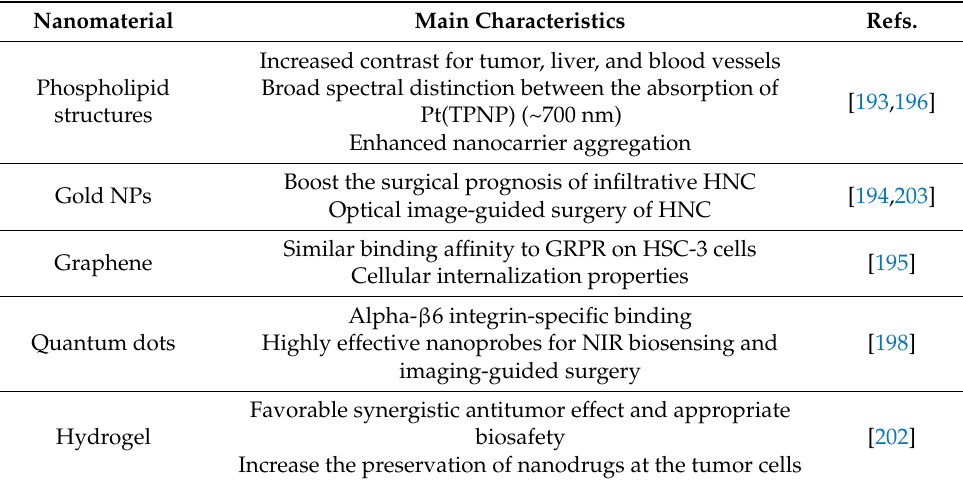
Table 2. Main characteristics of the different nanoparticle systems most used for the imaging of head and neck